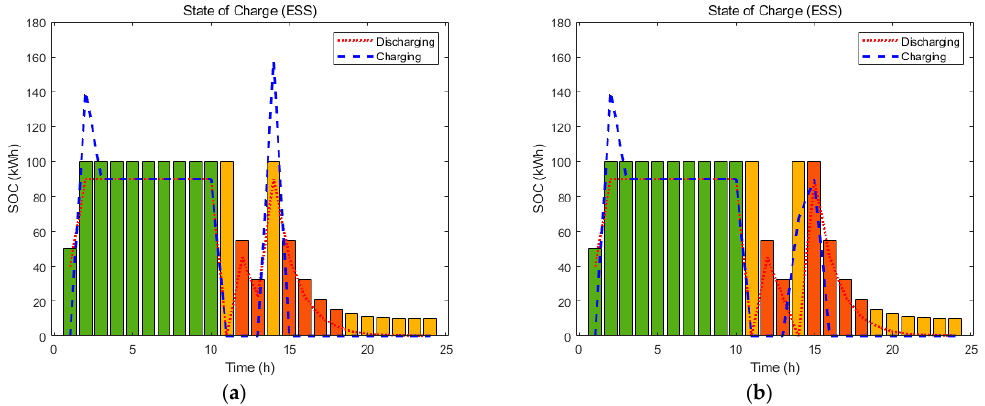
Figure 7. Optimal SOC of the energy-storage system (ESS) scheduling results in summer: ( a ) Without